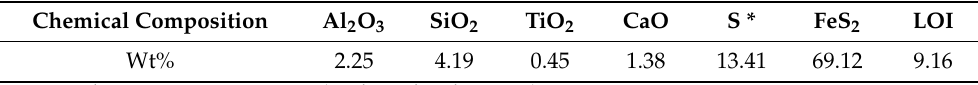
Figure 1. The XRD pattern of the phase composition of a pyrite sample. Table 1. The chemical composition of the pyrite sample as determined using XRF.